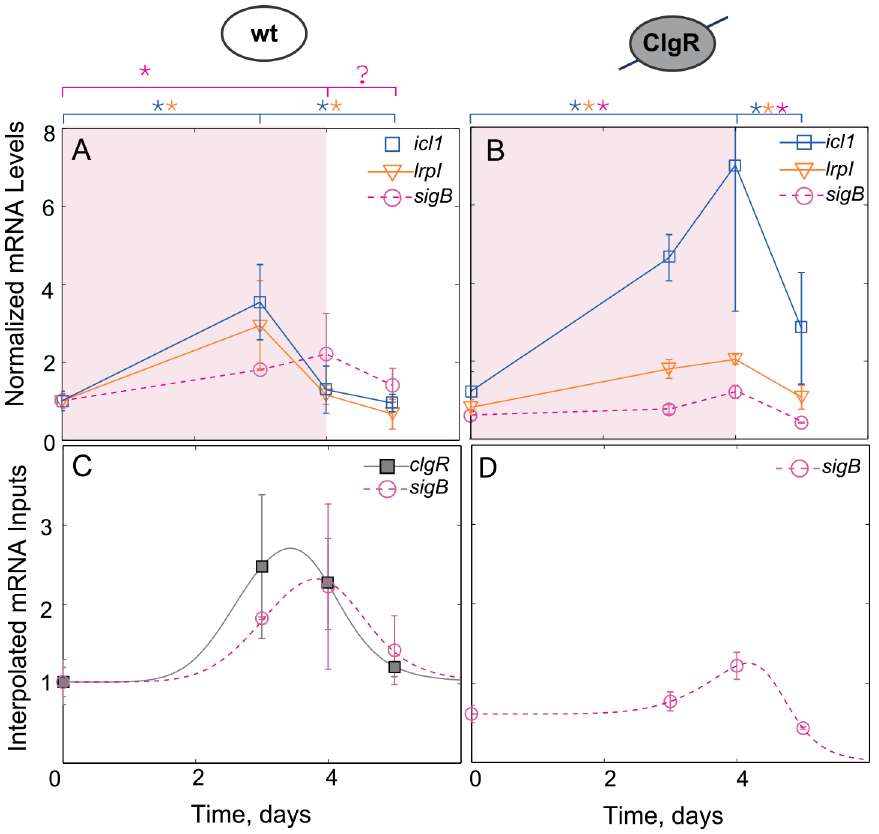
Fig 3. Gene expression measurements reveal a negative regulation of icl1 through clgR . (A,B) Expression measurements for icl1 , lrpI and the accessory sigma factor sigB mRNA for wild-type (A) and clgR knockout strain (B). (C,D) To simplify the model, the dynamics of sigB and clgR under hypoxia were interpolated for wild-type (C) and for clgR knockout strain (D) with a generalized pulse function and served as inputs into the model (See Methods for details). ( * p (cid:1)